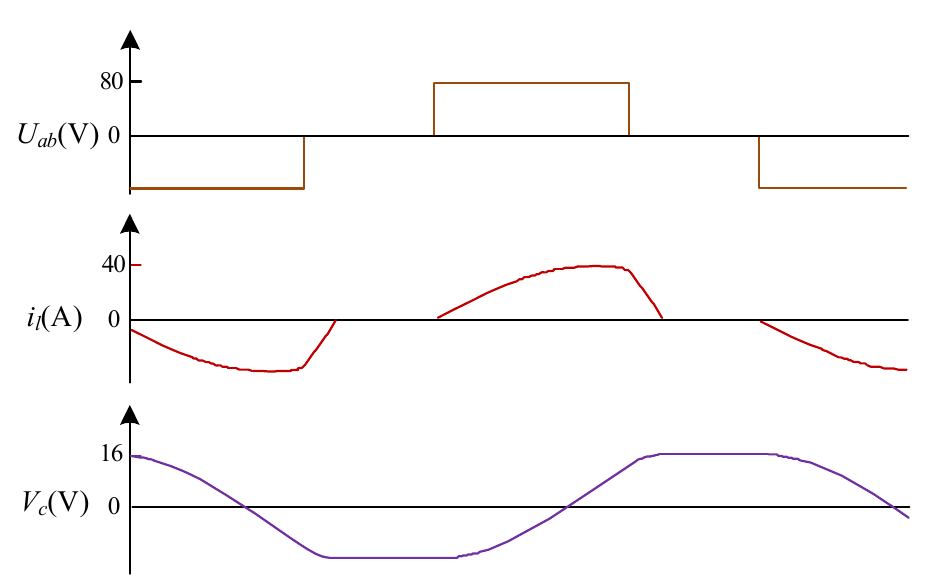
Figure 11. Simulation results at 60% duty ratio.